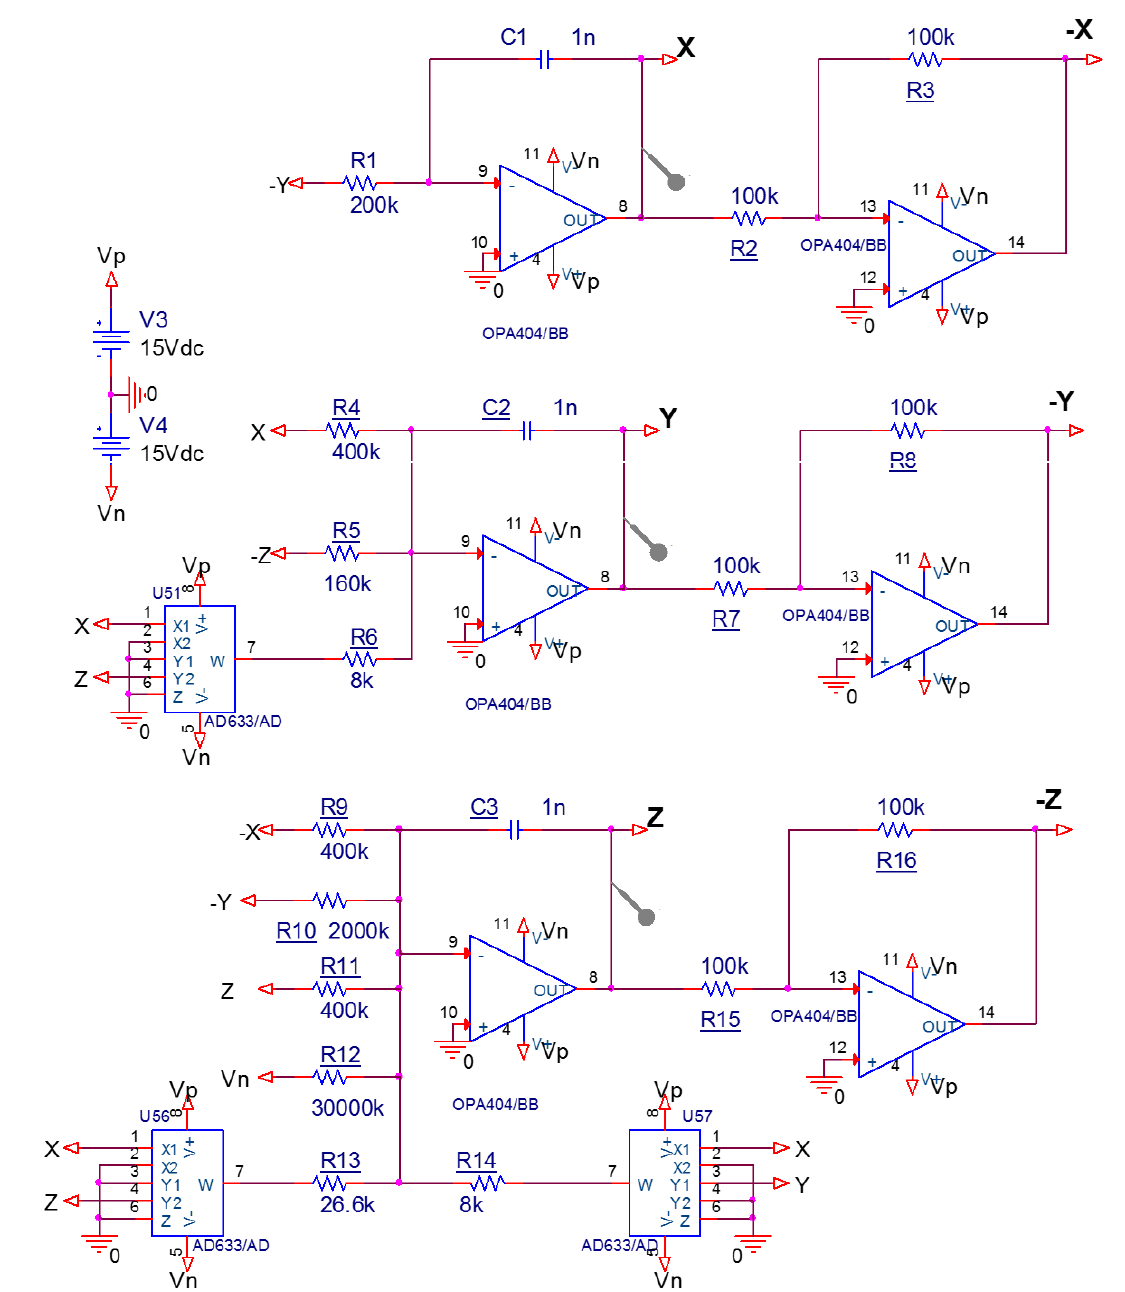
Figure 3. Circuit schematic including electronic